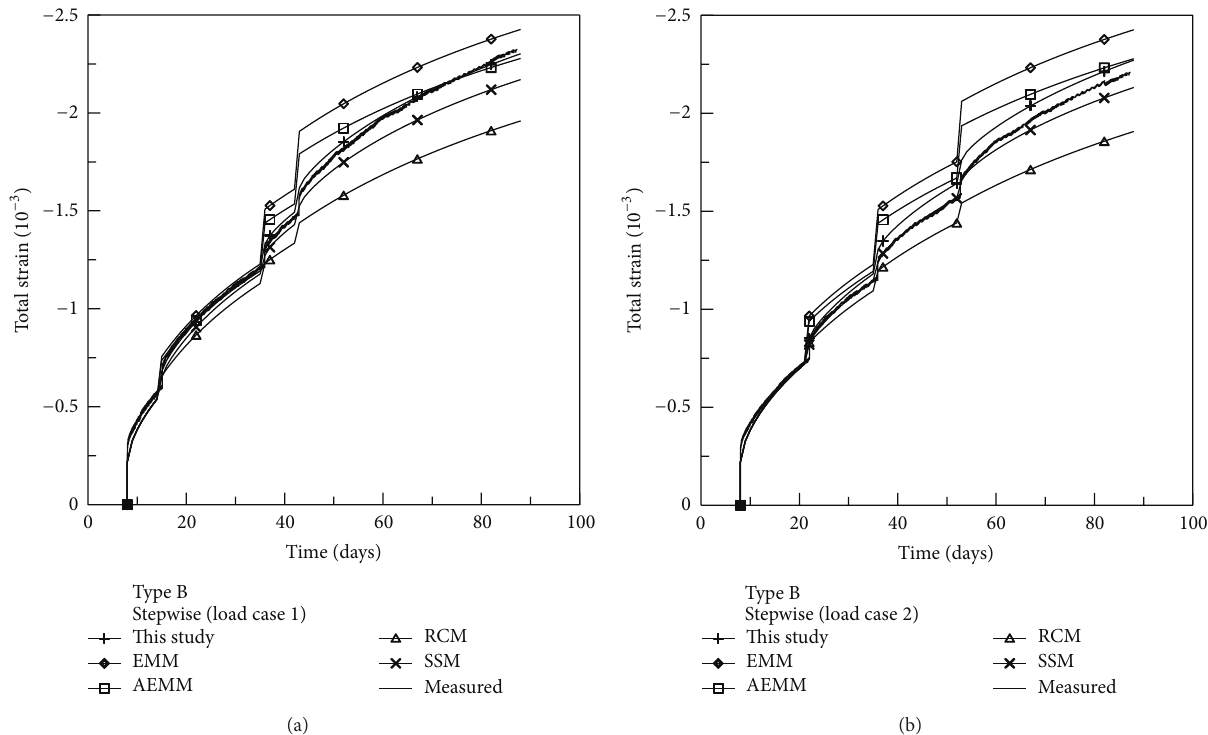
Figure 11: Comparison of the total strains predicted by the five creep models (type B test): (a) load case 1 and (b) load case 2.